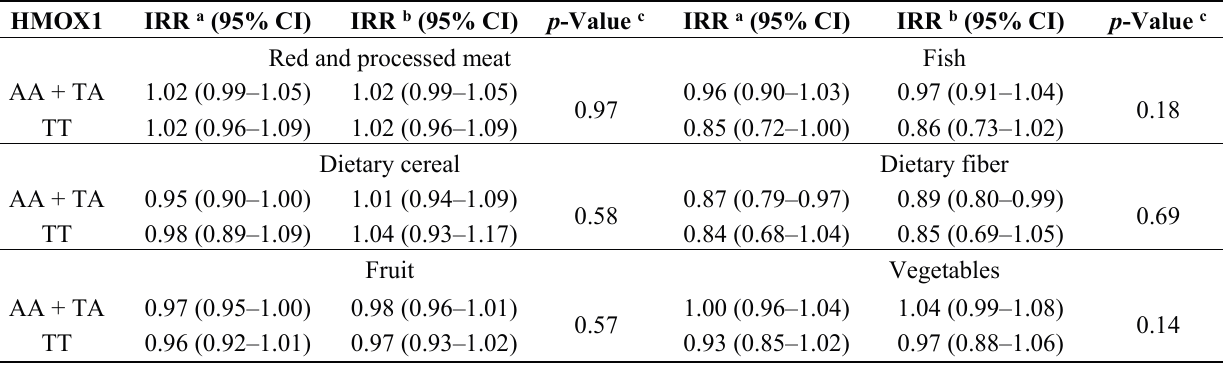
Table 3. Interaction between dietary factors and HMOX1 A-413T (rs2071746) in relation to colorectal cancer risk.